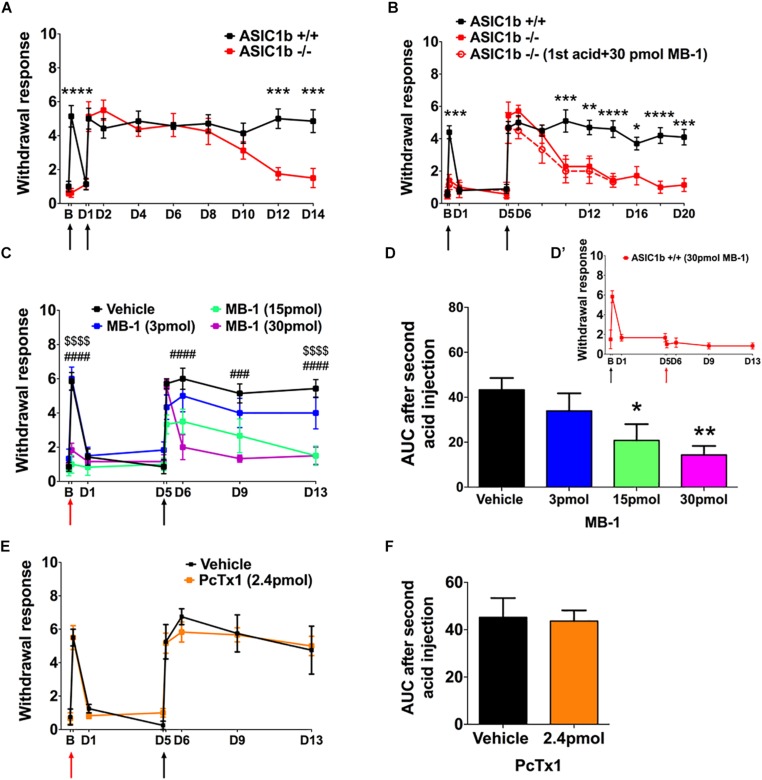
A role for ASIC1b in acid-induced mechanical hyperalgesia. (A) Mechanical hyperalgesia of wild-type (Asic1b+/+, N = 7) and ASIC1b-knockout (Asic1b– /–, N = 8) mice was induced by intramuscular injections of pH-4.0 saline on days 0 and 1 and evaluated by 0.20-mN von Frey filament. Data were analyzed by two-way ANOVA (Interaction F(10,143) = 5.34, P < 0.0001; Time F(10,143) = 14.5, P < 0.0001; Genotype F(1,143) = 23.11, P < 0.0001), followed by Sidak post hoc test. ∗∗∗P < 0.001 for genotype difference at specific times. (B) Mechanical hyperalgesia of Asic1b+/+ (N = 10) and Asic1b– /– (N = 7) mice was induced by intramuscular injections of pH-4.0 saline on days 0 and 5. Data were analyzed by two-way ANOVA [Interaction F(12,195) = 5.933, P < 0.0001; Time F(12,195) = 21.28, P < 0.0001; Genotype F(1,195) = 59.07, P < 0.0001], followed by Sidak post hoc test. ****P < 0.0001; ∗∗∗P < 0.001; ∗∗P < 0.01; ∗P < 0.05 Asic1b+/+ vs. Asic1b– /–. For comparison, the effect of mambalgin-1 on acid-induced hyperalgesia in Asic1b– /– mice was plotted. (C) Effect of mambalgin-1 (MB-1) on acid-induced mechanical hyperalgesia (vehicle, N = 7; MB-1 [3 pmol], N = 6; MB-1 [15 pmol], N = 7; MB-1 [30 pmol], N = 7). Data were analyzed by two-way ANOVA [Interaction F(21,168) = 4.014, P < 0.0001; Time F(7,168) = 26.61, P < 0.0001; Drug dose F(3,168) = 29.32, P < 0.0001], followed by Sidak post hoc test. ###P < 0.001, ####P < 0.0001, MB-1 (30 pmol) vs. vehicle; $$$$P < 0.0001, MB-1 (15 pmol) vs. vehicle. (D) Cumulative withdrawal response after second acid injection 5 days before acid + MB-1 injection is shown as the area under the receiver operating characteristic curve (AUC) calculated by the trapezoidal method. Data were analyzed by one-way ANOVA [F(3,21) = 4.719, P = 0.0114], followed by Dunnett post hoc test. ∗∗P < 0.01, ∗P < 0.05 vs. vehicle. (D’) While 30 pmole mambalgin-1 was applied in the second acid injection, it blocked the development of the acid-induced chronic hyperalgesia. (E) Effect of PcTx1 on acid-induced mechanical hyperalgesia. Data were analyzed by two-way ANOVA (vehicle, N = 4; PcTx1 [120 nmol], N = 6) Interaction F(7,64) = 0.2935, P = 0.9541; Time F(7,64) = 31.29, P < 0.0001; Drug dose F(1,64) = 0.054, P = 0.8169). (F) Cumulative withdrawal response after a second acid injection 5 days before acid + PcTx1 injection is shown as the AUC calculated by the trapezoidal method. Data were analyzed by unpaired t-test [F(3,5) = 2.191, P = 0.4149). Black arrows, the time mice received intramuscular injection of pH 4.0 saline. Red arrows, the time mice received intramuscular injection of pH-4.0 saline mixed with mambalgin-1 or PcTx1. B, baseline. Data are mean ± SEM.